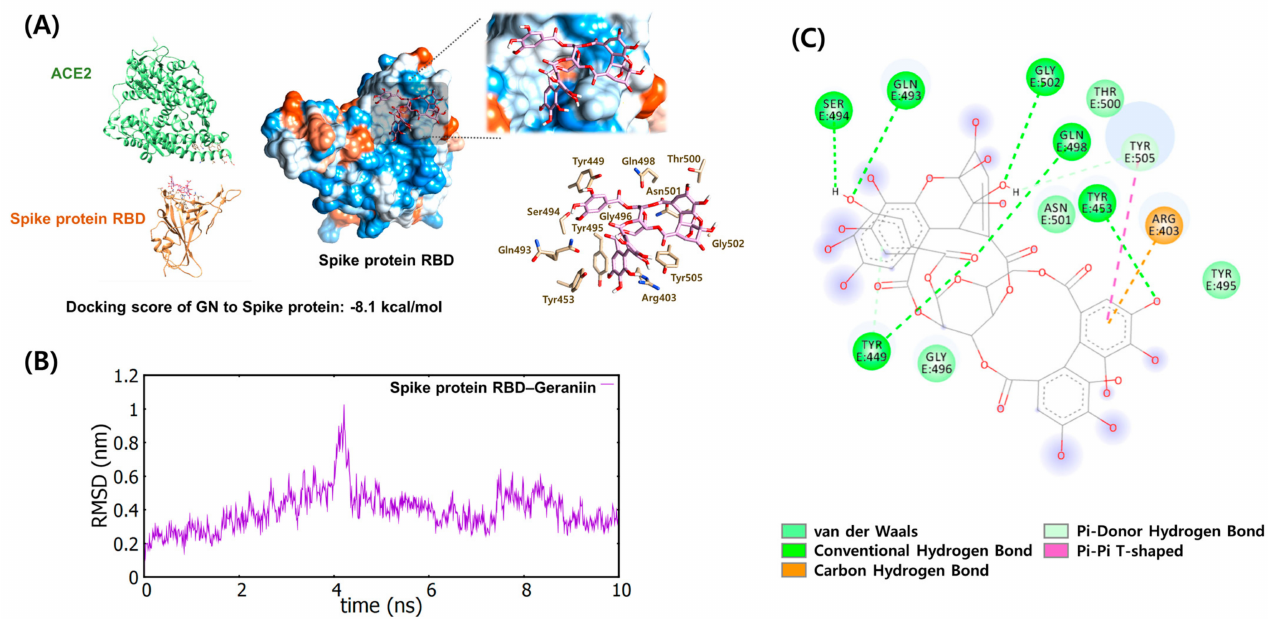
Figure 3. Protein-ligand docking simulation and analyses. ( A ) Docking simulation between geraniin and spike protein. Geraniin was docked onto the SARS-CoV-2 spike protein and hACE2 receptor derived from the spike protein/hACE2 receptor complex (PDB code 6M0J) using AutoDock Vina. ( B ) The molecular dynamics of spike protein–geraniin complex were performed using Gromacs 5.1.2. ( C ) The molecular interactions between geraniin and the spike protein were analyzed using BIOVIA Discovery Studio